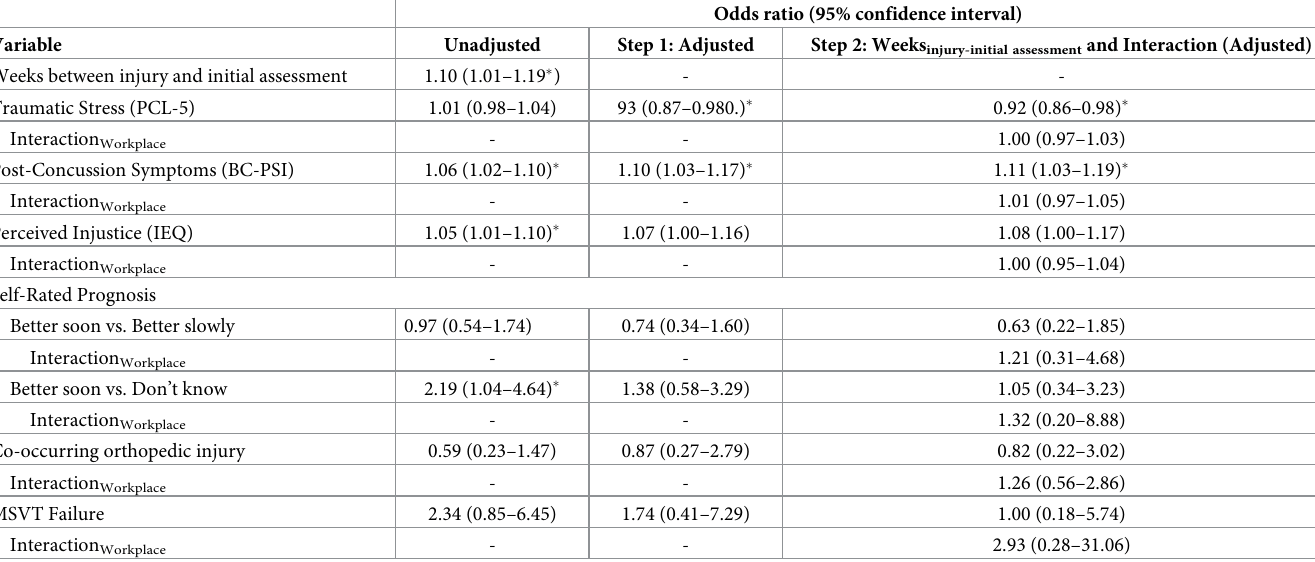
Table 3. Logistic regression results of return to work (RTW; any work vs. no work) status at follow-up.